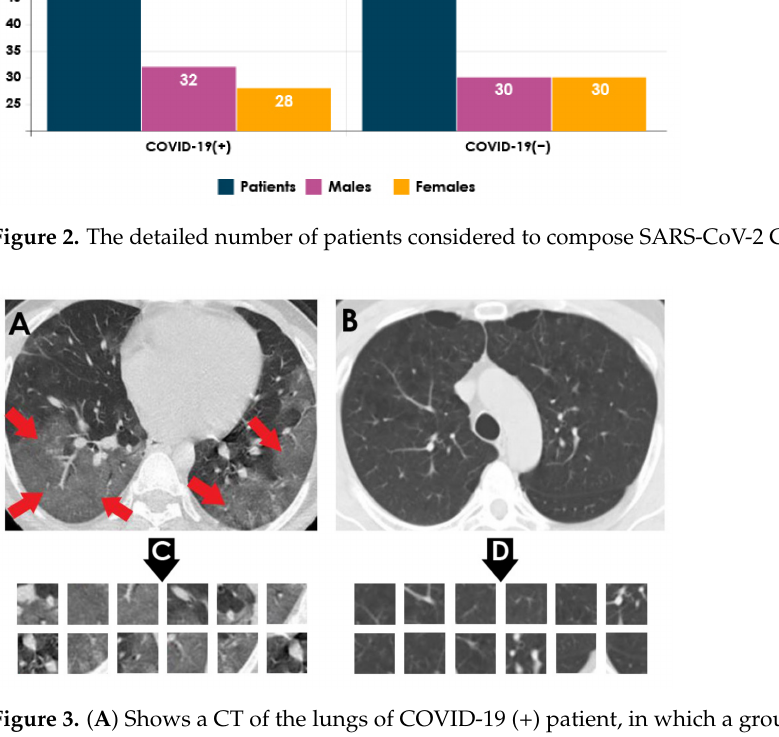
Figure 3. ( A ) Shows a CT of the lungs of COVID-19 (+) patient, in which a ground-glass opacity is visible in the lower lobes (red arrows). ( B ) Represents a CT of the lungs of COVID-19 ( − ) patient, in which there are no abnormalities. ( C ) Depicts infected patch samples. ( D ) Reflects non-infected patch samples. SARS-CoV-2 CT-scan dataset [42] is the source for these